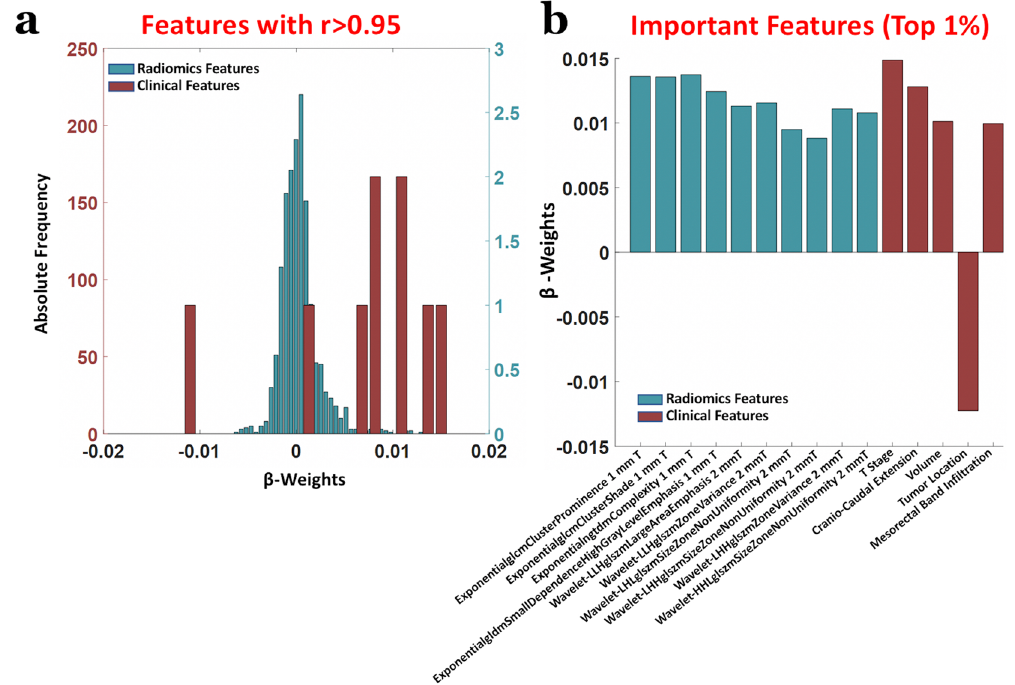
Figure 5. ( a ) Distributions of the PLS β-weights of radiomic and clinical features when the machine learning analysis was performed on combined data. ( b ) β-weights associated to the top 1% of features with the largest β-weights in magnitude, i.e. those most impacting the